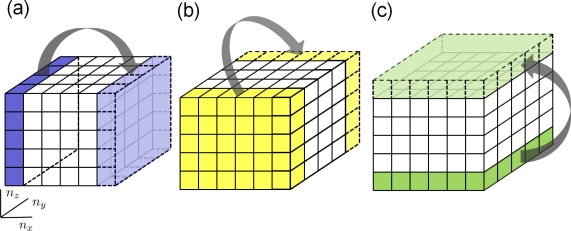
Schematic of the sequential construction of different ghost cell layers. An individual cell of the simulation box can be identified by the three integers (ix, iy, iz). The original box in this example has nx = nz = 5 and ny = 4 cells in each direction, i.e., there is no need for the simulation box to have cubic shape. (a) In a first step, all particles of cells with indices (ix = 1; iy = 1, ..., ny; iz = 1, ..., nz) are copied into the first layer of ghostparticles. The second layer of ghostparticles then contains all particles pertaining to cells (ix = 1, ..., nx; iy = 1; iz = 1, ..., nz) including the ghostparticles of the ghostcells from the first ghostlayer. Finally, the third layer of ghostcells is constructed by copying the particles of the cells with (ix = 1, ..., nx; iy = 1, ..., ny; iz = 1) as indicated in the figure.